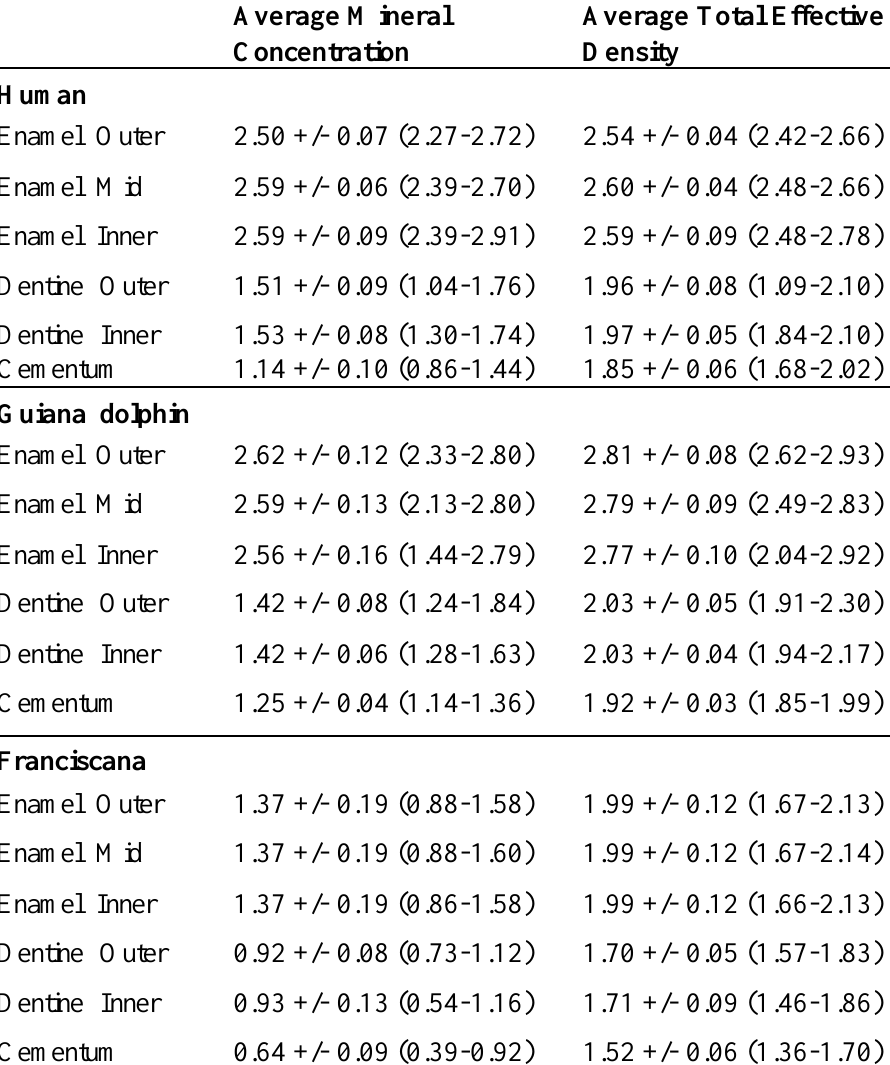
Table 2. Summary of average mineral concentration and total effective density (in g/cm 3 ) ± SD in human and odontocete dental samples. Maximum and minimum values observed are in